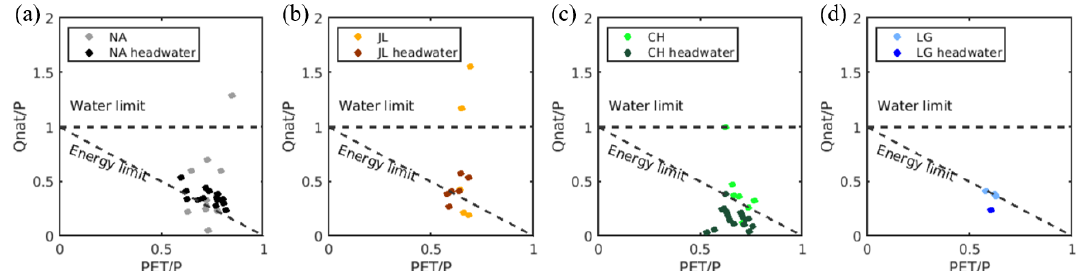
Figure 6. Annual average reach water balance metrics for the Thames at Kingston reaches from 1994–2014 inclusive, showing dimensionless reach runoff coefficient (river flow/precipitation) and dryness index (potential evapotranspiration/precipitation) in relation to the water limit, the energy limit and their headwater (i.e. no upstream gauge) or “non-headwater” location along the river, under naturalised conditions. Reach categorisations are based on > 70% catchment geological coverage of NA: non-aquifer ( n = 28), JL: Jurassic limestone ( n = 11), CH: Chalk ( n = 23) and LG: Lower Greensand ( n = 4). The results from the three Lower Thames reaches are not shown on panel (a) as they have negative reach runoff coefficient